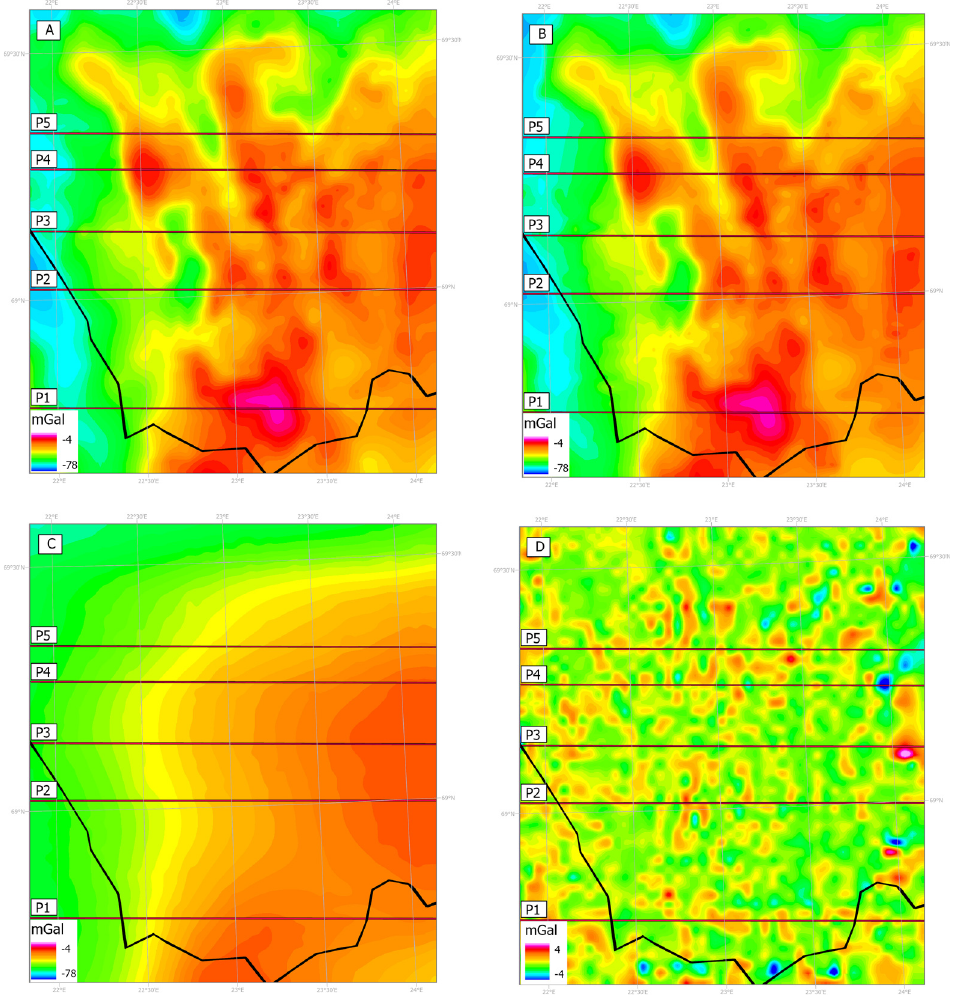
Figure 13. Measured and calculated gravity fields. (A) Measured data, (B) calculated data, (C) regional field and (D) residual gravity field (subtraction of the calculated field from the measured data). P1-P5: selected profiles with the